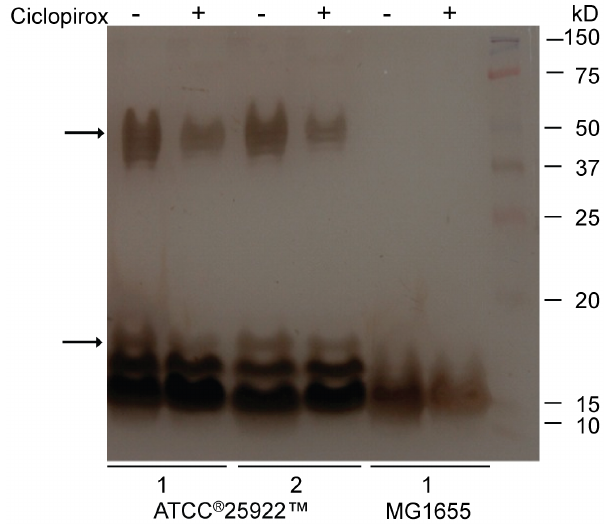
Figure 7. Effect of ciclopirox on E.coli LPS structure. LPS was purified from E. coli clinical isolate ATCC H 25922 TM or K-12 strain MG1655 that had been either incubated with 9 m g/ml ciclopirox as indicated. LPS was subjected to 12.5% Tris-glycine-SDS-PAGE. Lanes 1 and 2 are LPS from two independent LPS purifications. This result was repeated six times with the same